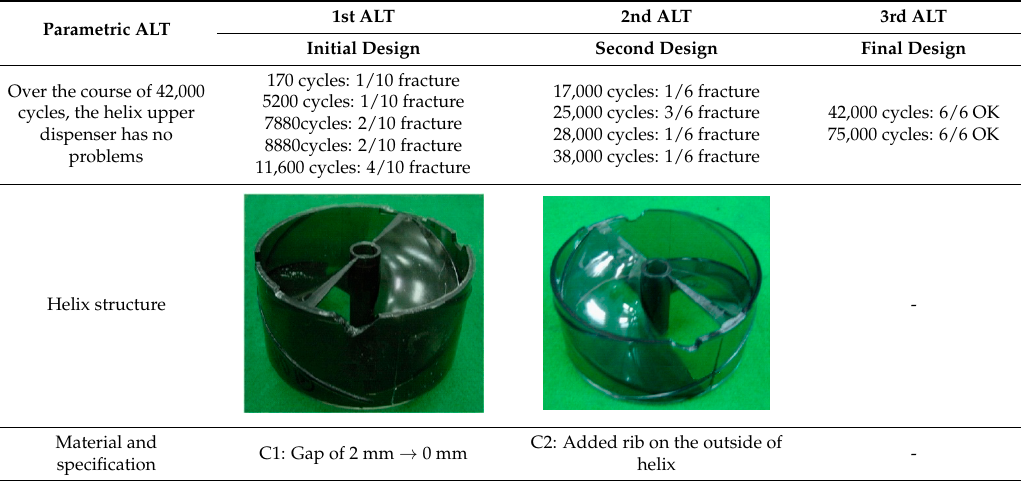
Table 2. Results of ALTs.